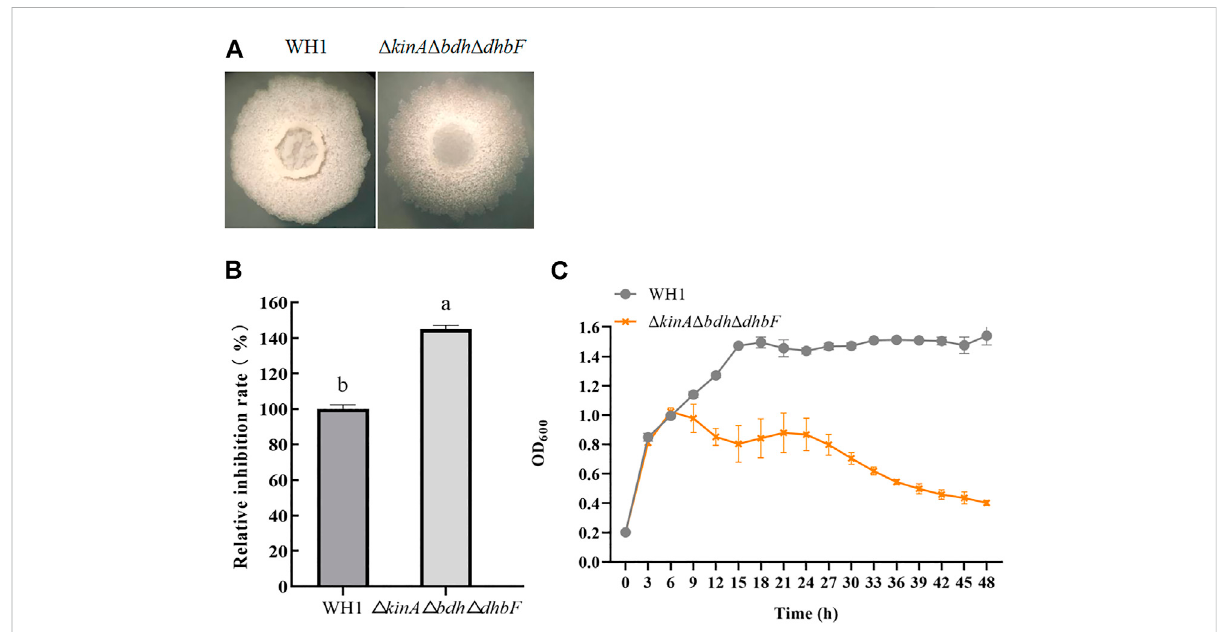
FIGURE 6 Relative inhibition rate and characteristic of Δ kinA Δ bdh Δ dhbF . (A) : Colony morphology; (B) : Relative inhibition rate; (C) : Growth